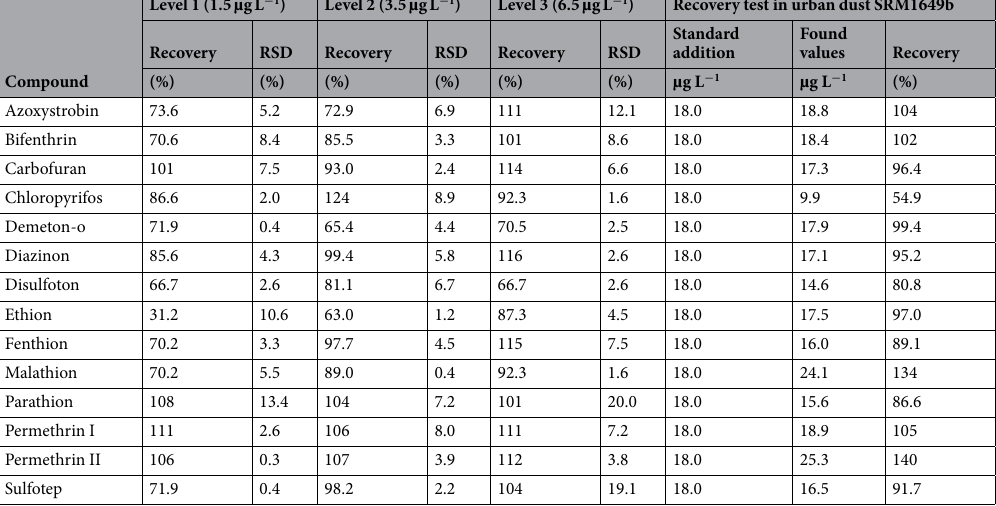
Table 2. Mean recovery of pesticides in blank filters (n = 2) and NIST Standard Reference Material urban dust